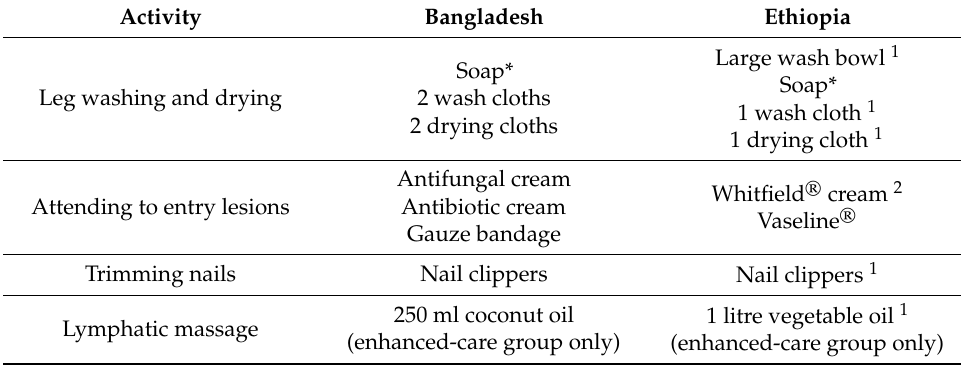
Table 3. Materials supplied to participants to perform lymphedema self-care. The supplies provided are in keeping with government policy in each